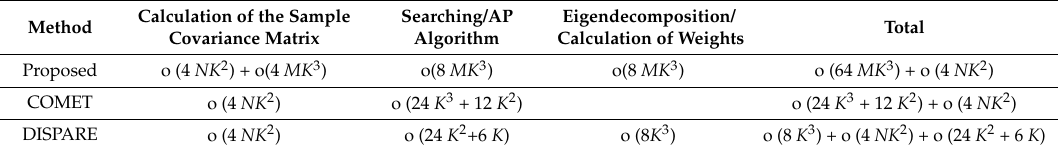
Table 1. Computational complexity of different